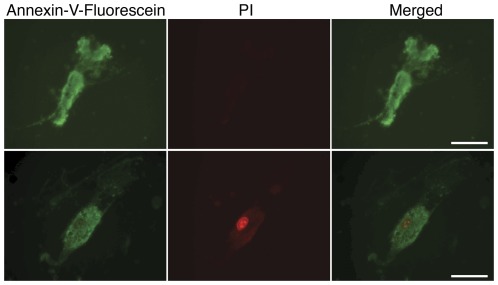
Apoptosis assay of hMSCs.Representative images of cells stained positive for annexin-V-fluorescein (green) alone or positive for both annexin-V-fluorescein and propidium iodide (PI, red) are presented. Scale: 50 µm.